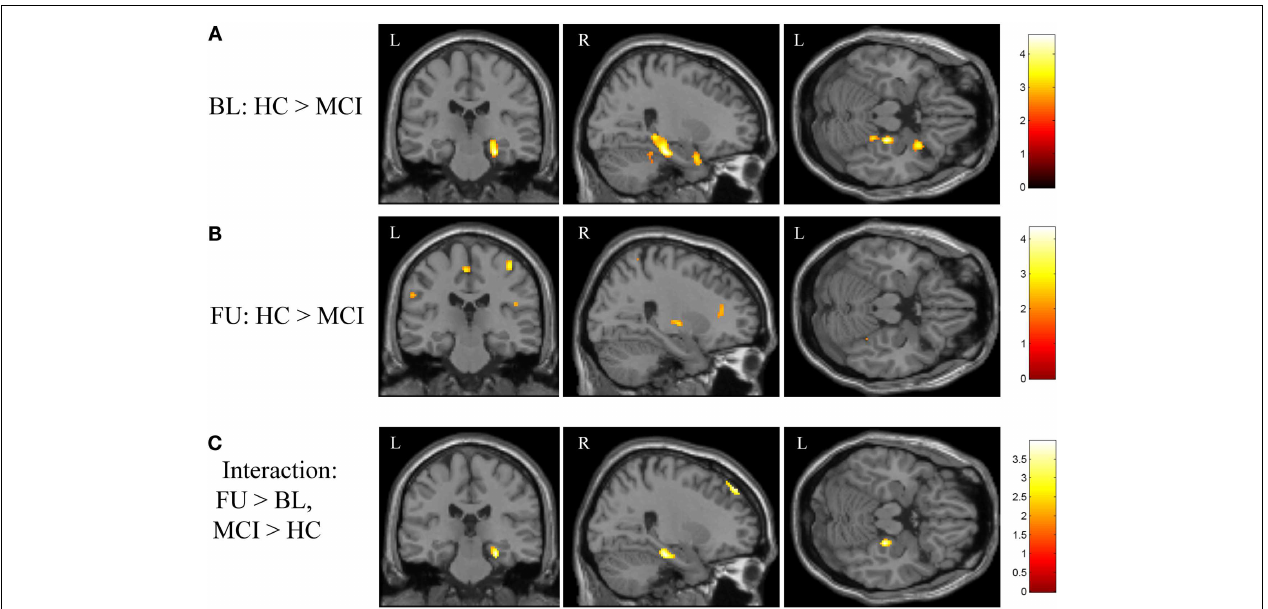
demonstrated that MCI patients showed a greater increase in brain activation in the right medial temporal lobe after donepezil treatment relative to HC. All panels are displayed at a voxel-wise threshold of p < 0.01 (uncorrected) and a minimum cluster size ( k ) = 50 voxels. However, most of the observed clusters have local maxima that reach a voxel-wise threshold of p < 0.001 (uncorrected; see TableA1 in Appendix). See the Section “Results” and TableA1 in Appendix for additional results. FU = follow-up, BL = baseline, MCI = mild cognitive impairment, HC = healthy older adults, R = right, L = left.